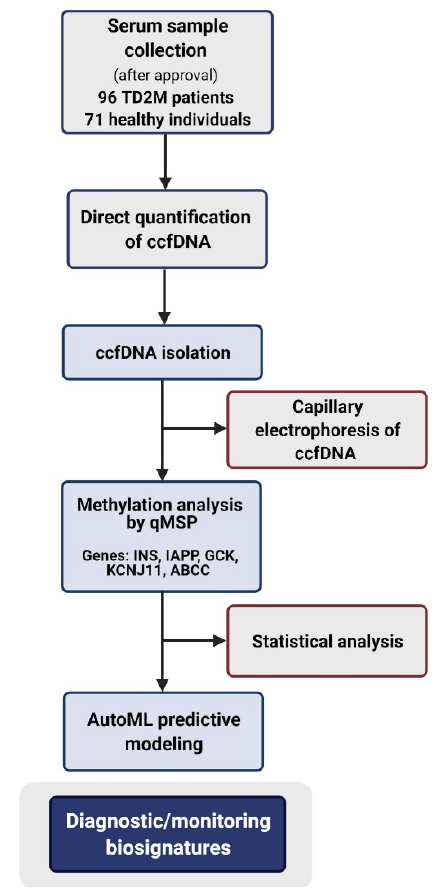
Figure 1. Workflow of our study. Abbreviations: TD2M: Type 2 diabetes mellitus, ccfDNA: circulating cell free DNA, qMSP: quantitative Methylation Specific PCR, AutoML: Automated Machine Learning.